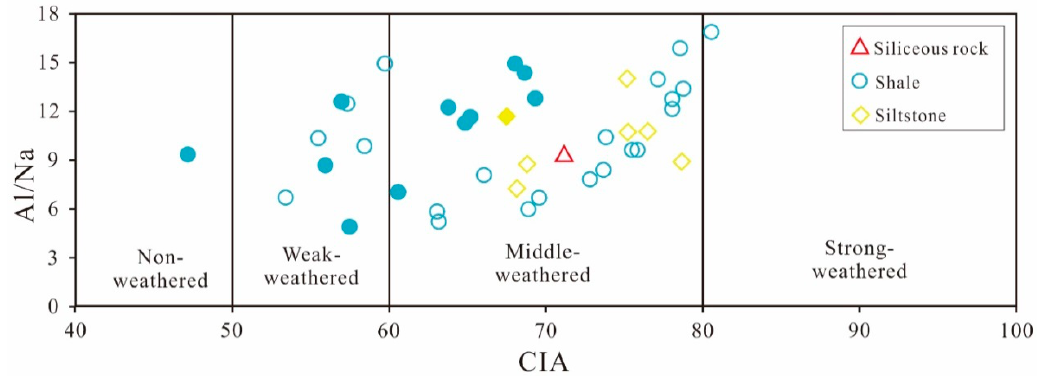
Figure 8. Cross plot of chemical index of alteration (CIA) values versus Al/Na ratios demonstrating the weathering degree of sediment provenance. Hollow points are the samples from SQ-1 and solid points are the samples from CY-1.